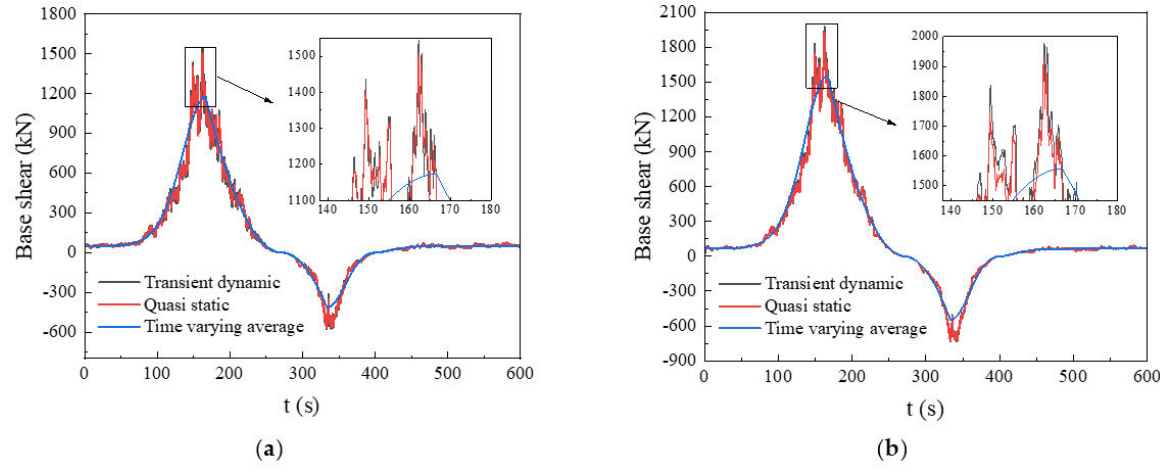
Figure 11. Time history of base shear response: ( a ) single tower; ( b ) tower-line